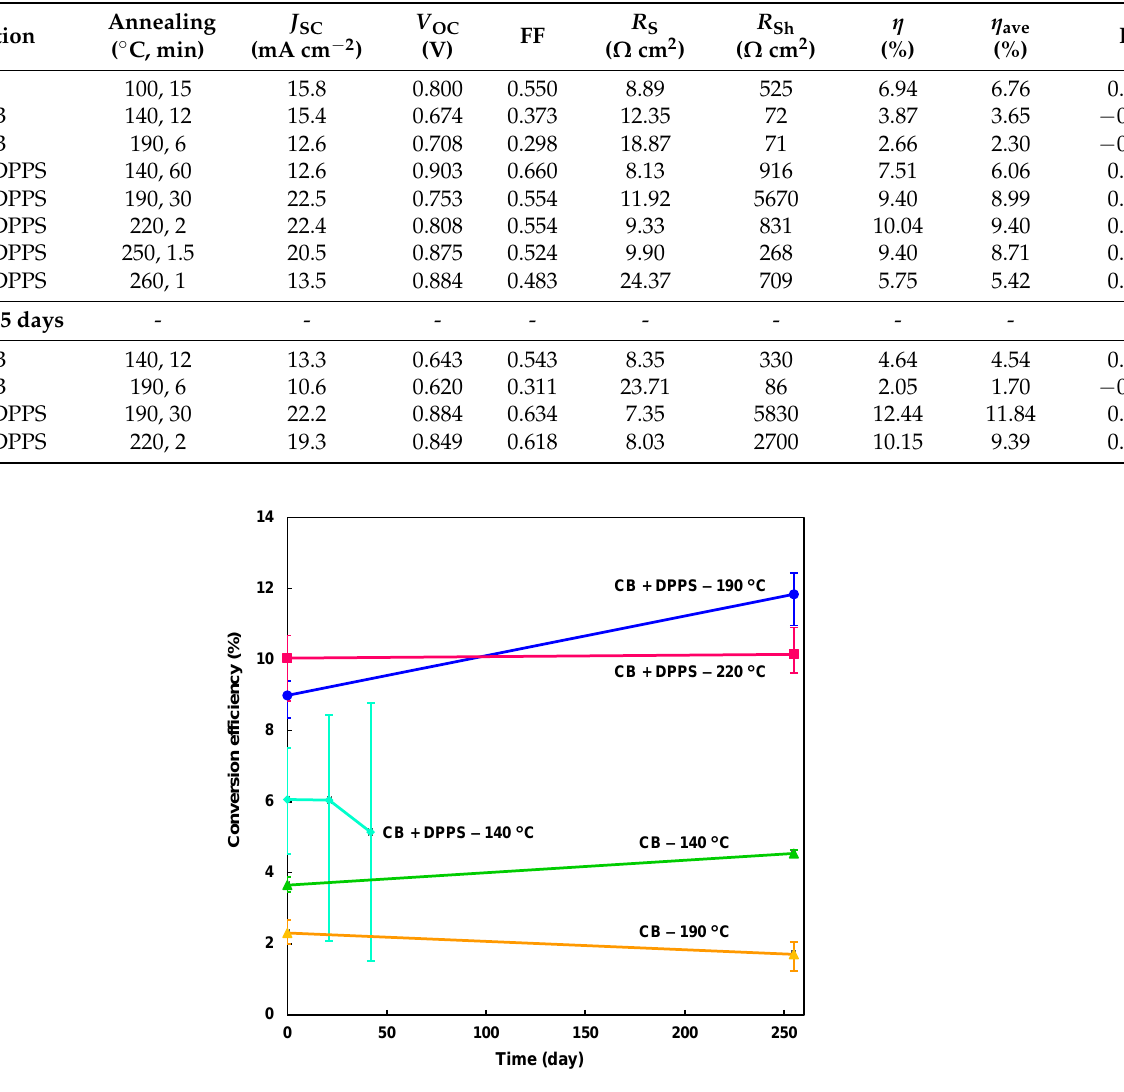
Table 1. Photovoltaic parameters of perovskite photovoltaic devices. * Prepared from CH 3 NH 3 I:PbI 2 = 1:1 and without air blowing.